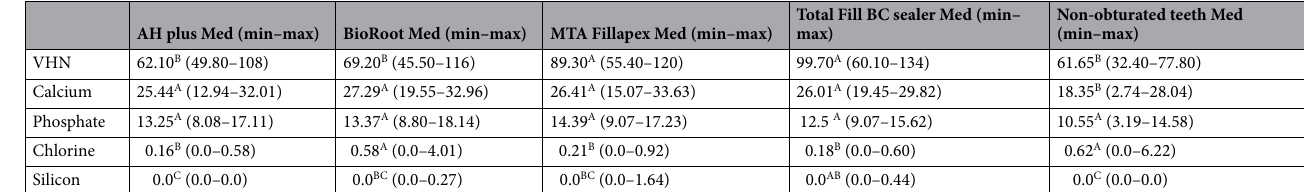
Table 4. Median (Med). Minimum (Min) and Maximum (Max) values of the Vickers hardness number (VHN) of dentin surface after root canal obturation and it percentage of calcium, phosphate, chlorine and silicon obtained from the Energy Dispersive Spectroscopy (EDS) chemical analysis. Different capital letters in rows indicate statistically significant intragroup differences (Kruskal–Wallis with a Dunn post hoc P value <